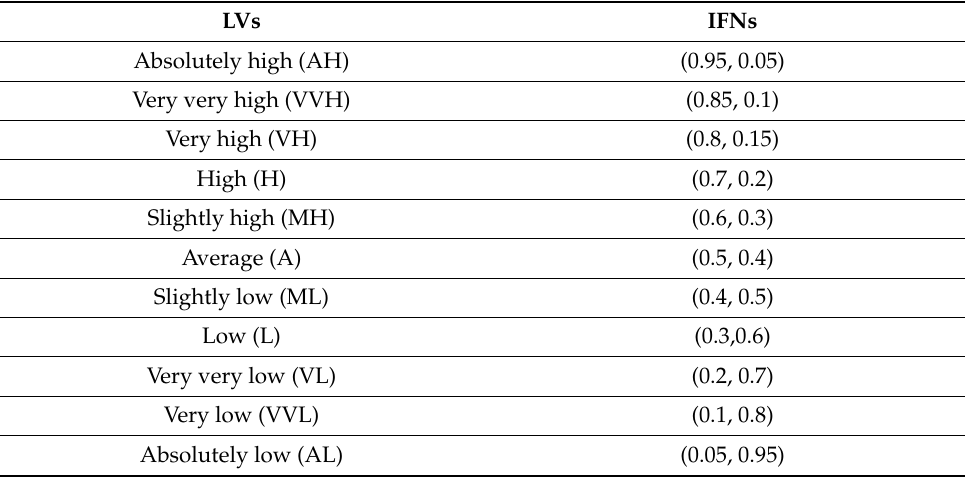
Table 2. LVs for options for prioritizing